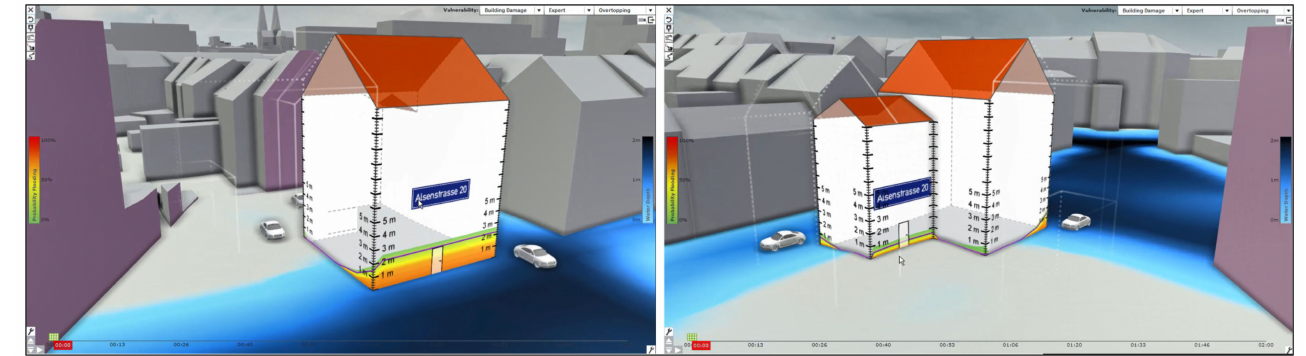
Figure 16. Rotation along the contour edges of the building object of interest with corresponding water levels mapped on each façade for an informed flood risk assessment and planning of appropriate mitigation measures: side view of the building ( left ); back view of the building ( right ) The colors denote a range from 0% probability (green) to a 100% probability